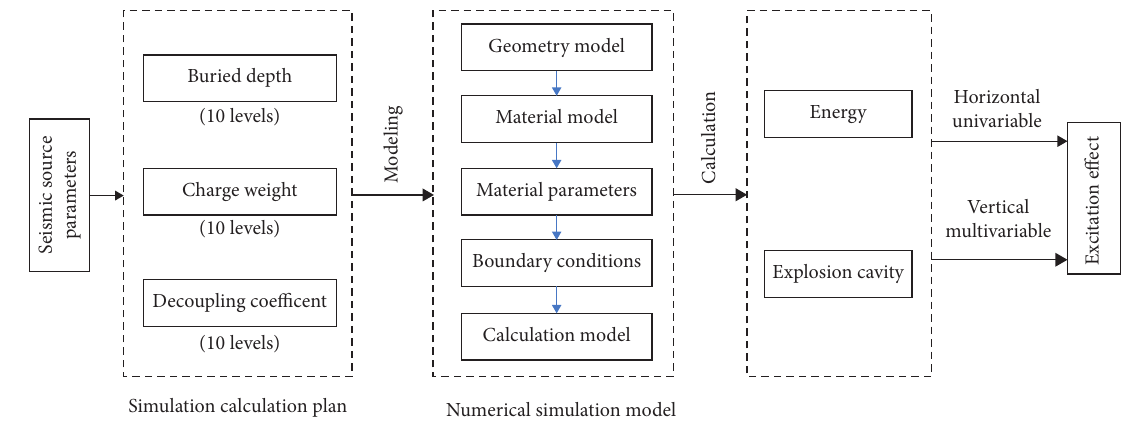
Figure 1: Research plan of this study.